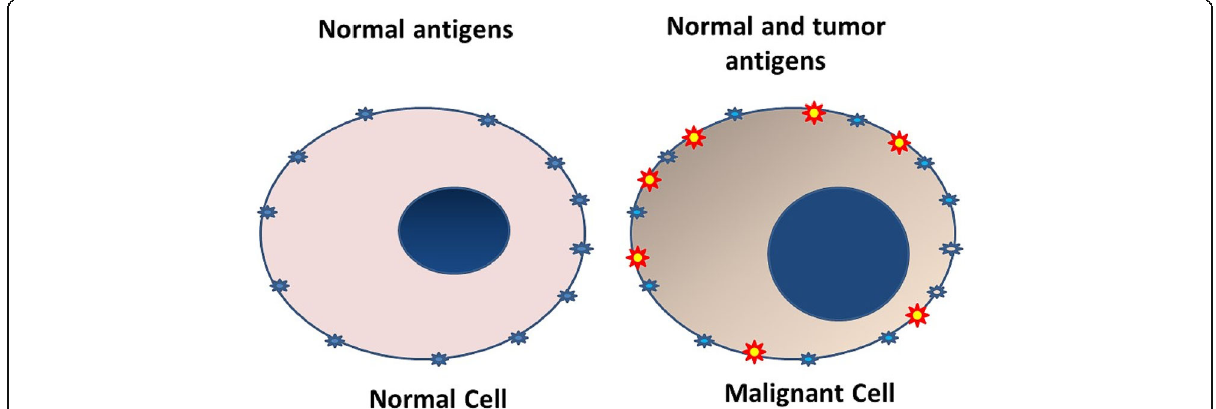
Fig. 1 Cartoon showing surface antigens on a normal cell, compared with a cancer cell which has the normal antigens as well as additional cancer-specific and cancer-related antigen (shown as yellow-red)